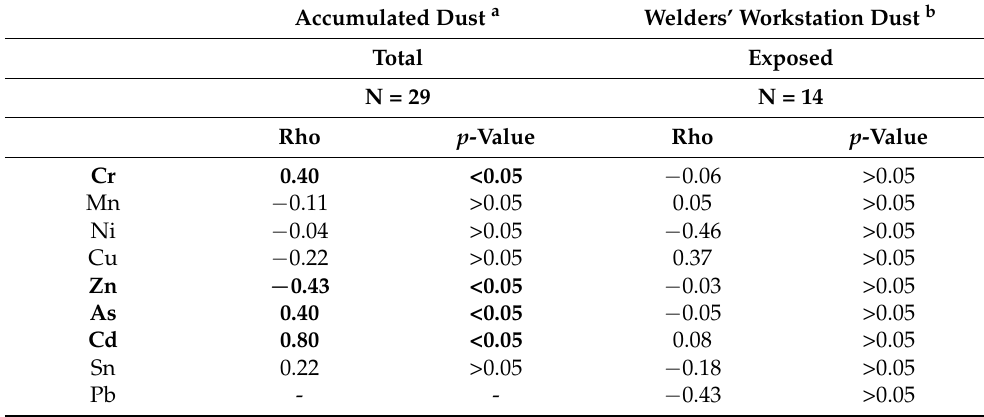
Table 6. Spearman correlations of PTE levels in children’s blood (0–11 years) and in dust samples. Limeira, Brazil,